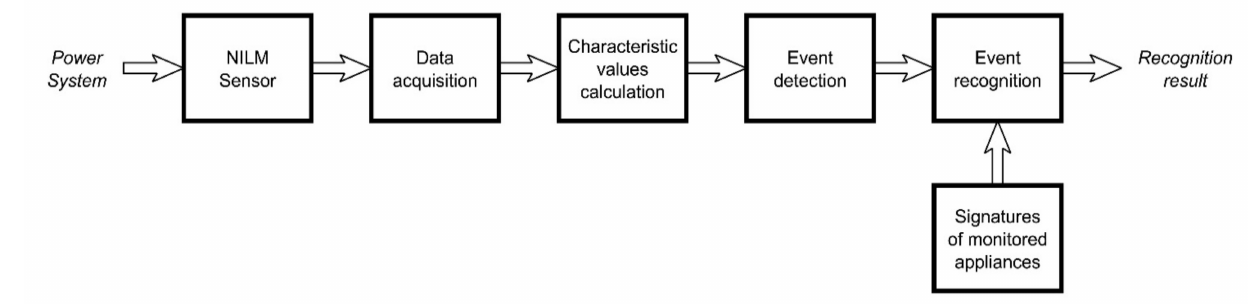
Figure 1. General architecture of a non-intrusive load monitoring